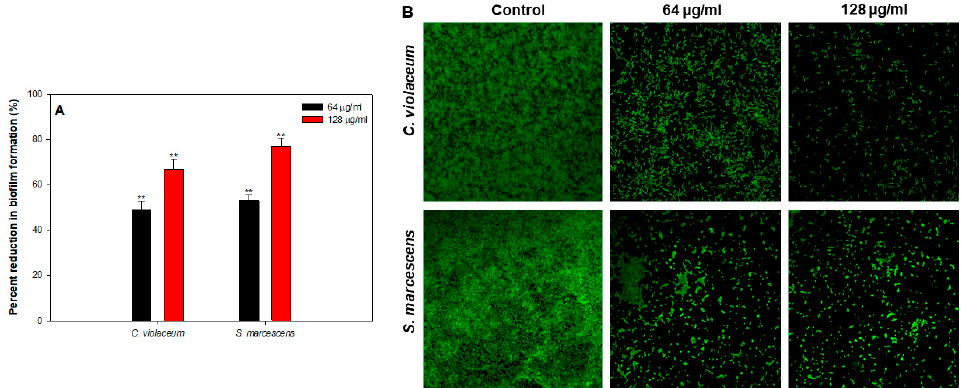
Figure 9. ( A ) E ff ect of sub-MICs of ZnO@XG on the biofilm formation of C. violaceum 12472, and S. marcescens ATCC 13880. Data are represented as mean values of triplicate readings, and the bar is the standard deviation. ** denotes significance at p ≤ 0.005. ( B ) confocal laser scanning microscopic images of C. violaceum 12472 and S. marcescens ATCC 13880 biofilm in the absence and presence of sub-MIC